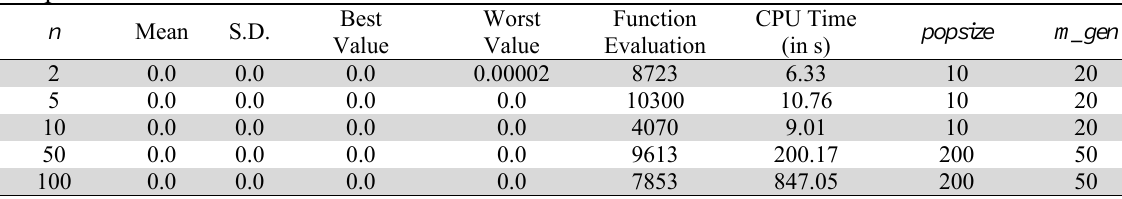
Computational Results of Problem -1